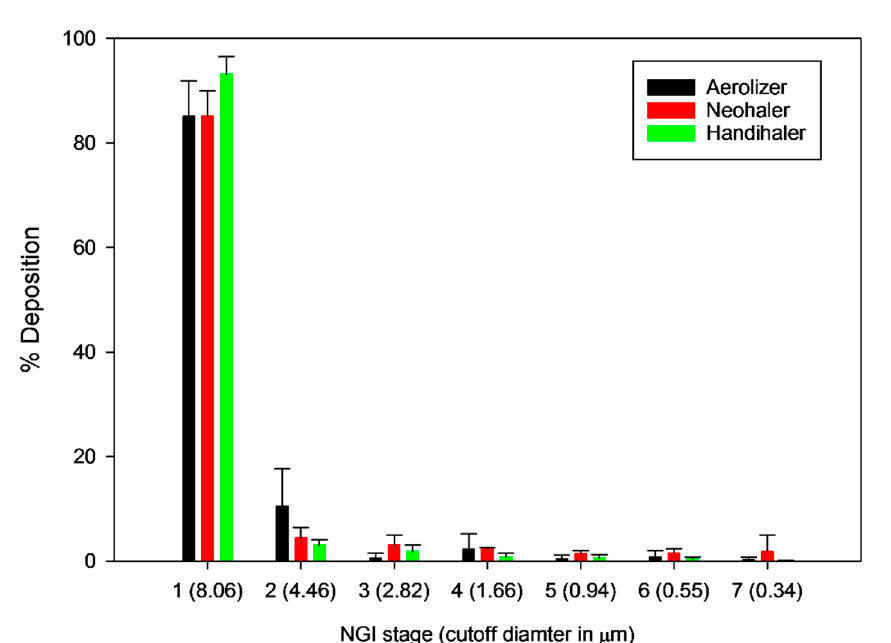
Figure 7. In vitro aerosol deposition of spray dried TMP particles using human dry powder inhaler (DPI) devices Aerolizer ® , Neohaler ® and Handihaler ® using NGI ® at 60 L/min flow rate. ( n = 3, mean ± SD).